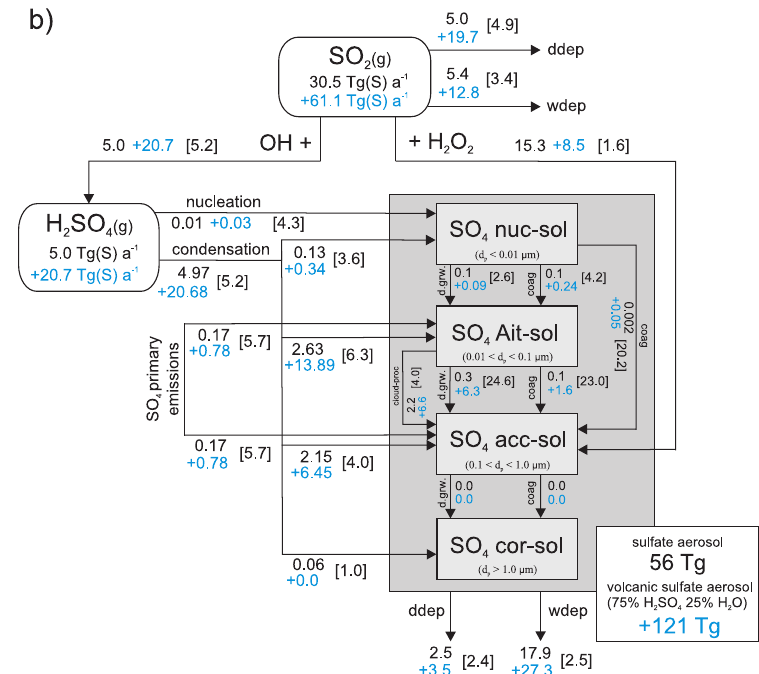
Fig. 4b. As Fig. 4a but 12-month mean sulphur budget shown for L-w.